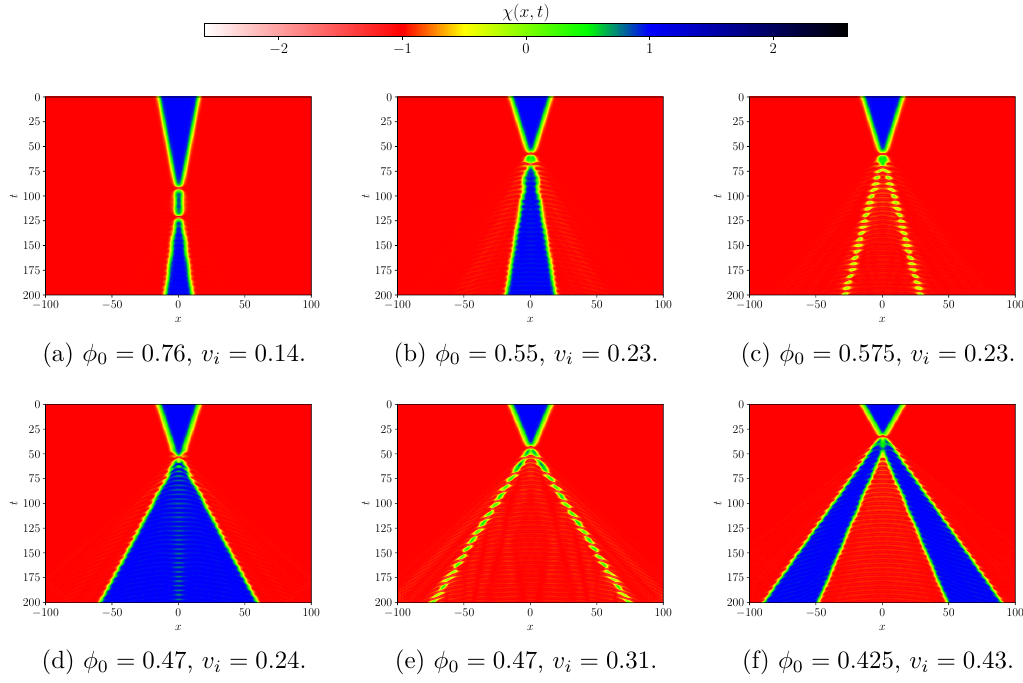
Figure 10 . Scalar field evolution in spacetime. We consider the case where the fermions start at the excited